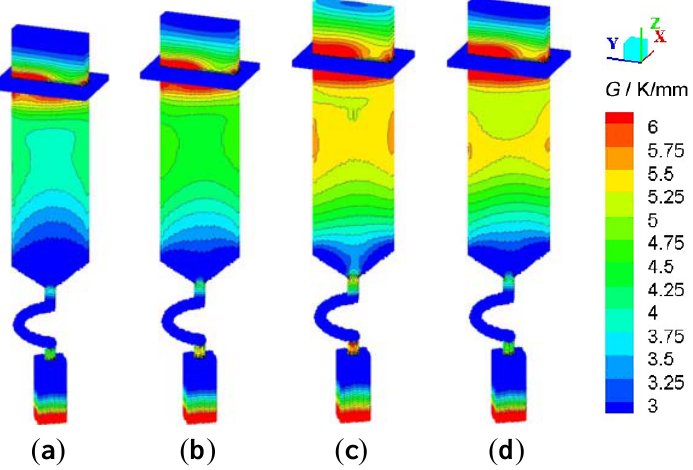
Figure 11. Temperature gradients of mushy zones during DS process ( a ) SG1; ( b ) SG2; ( c ) SG3; ( d )